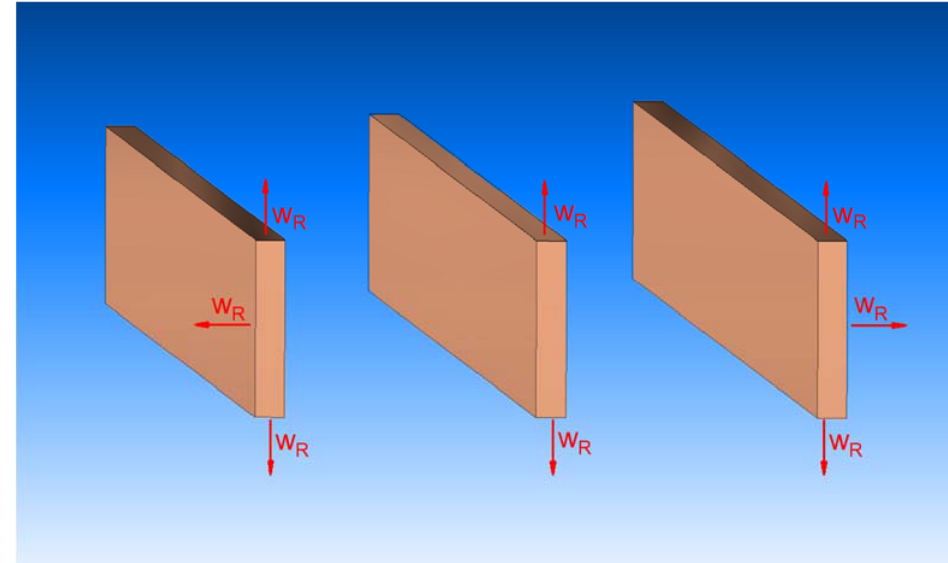
Figure 3. A scheme of heat dissipation from vertical busbars in the switchgear.